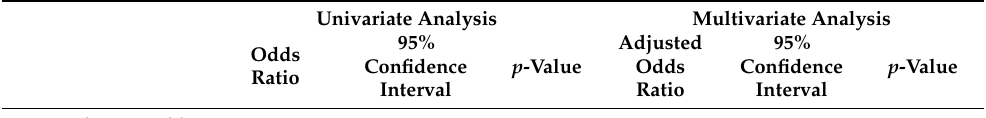
Univariate Analysis Multivariate Analysis 95% Adjusted 95% Odds p -Value p Confidence Odds Confidence Ratio Interval Ratio Interval